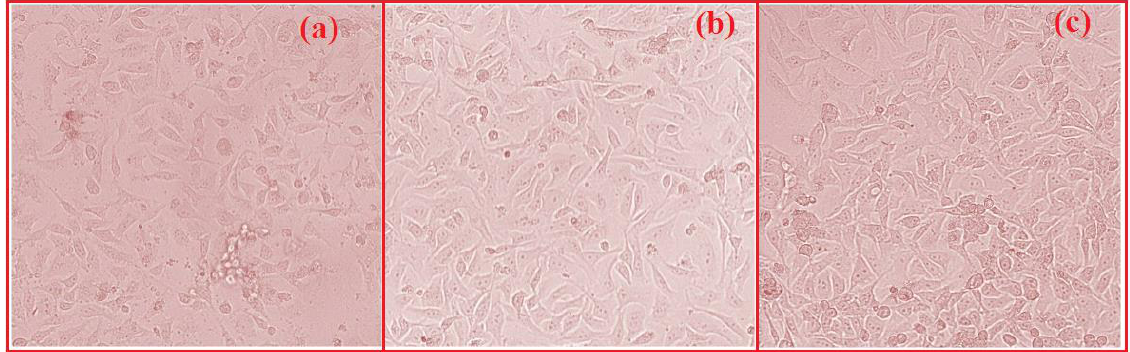
Figure 10. ( a ) controlled, ( b ) ZCC treated cells—24 h, ( c ) ZCC treated cells—48 h.